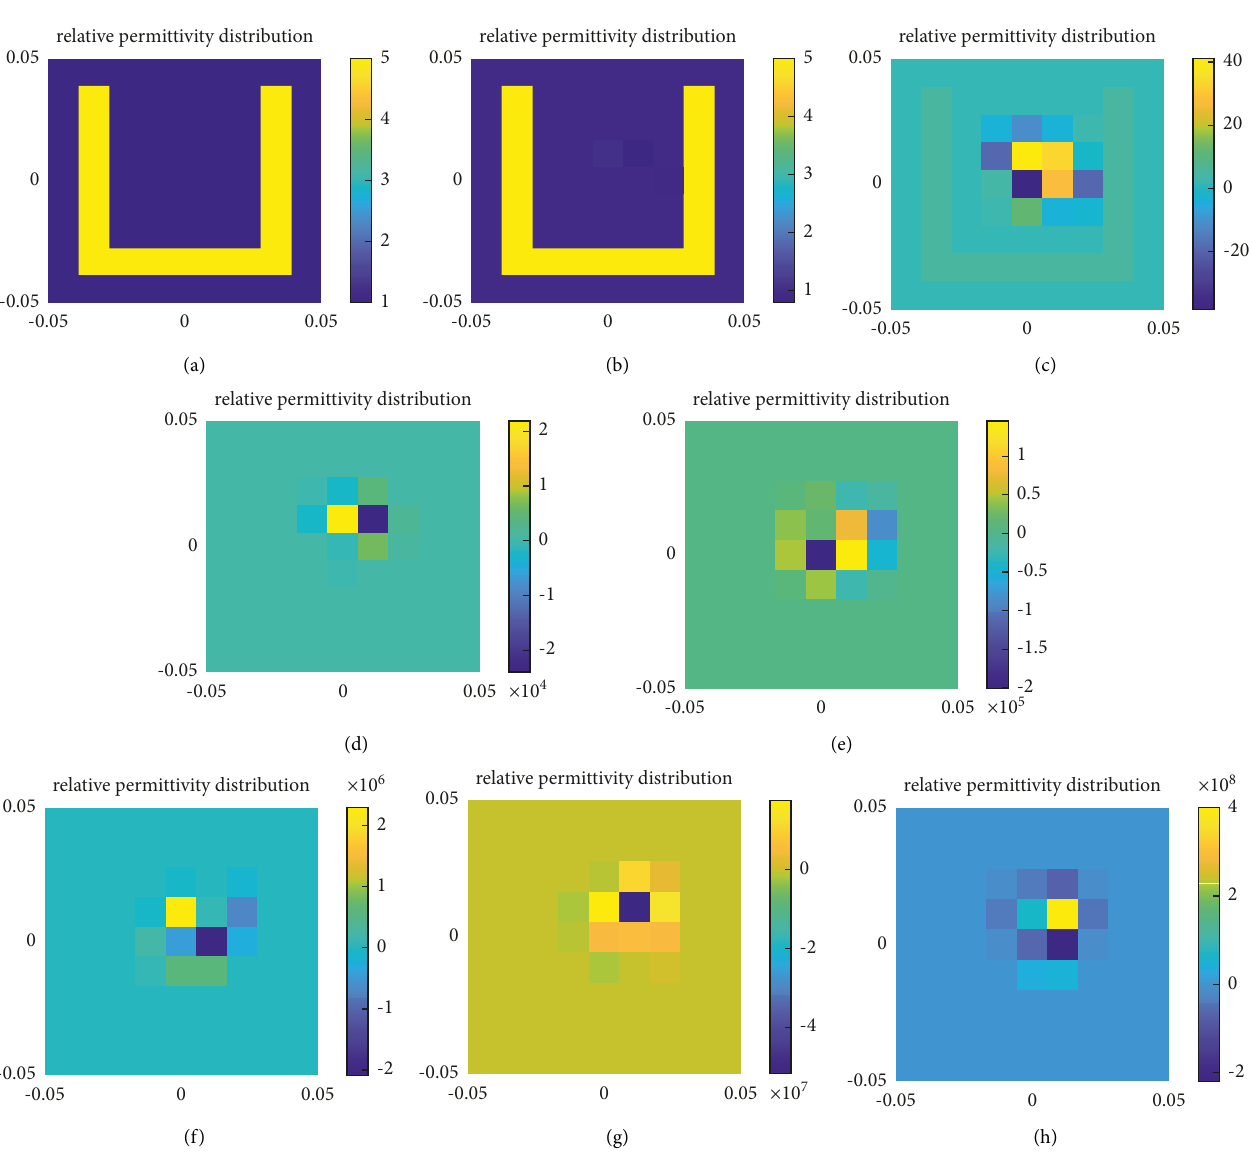
200. (c) Snr (cid:31)